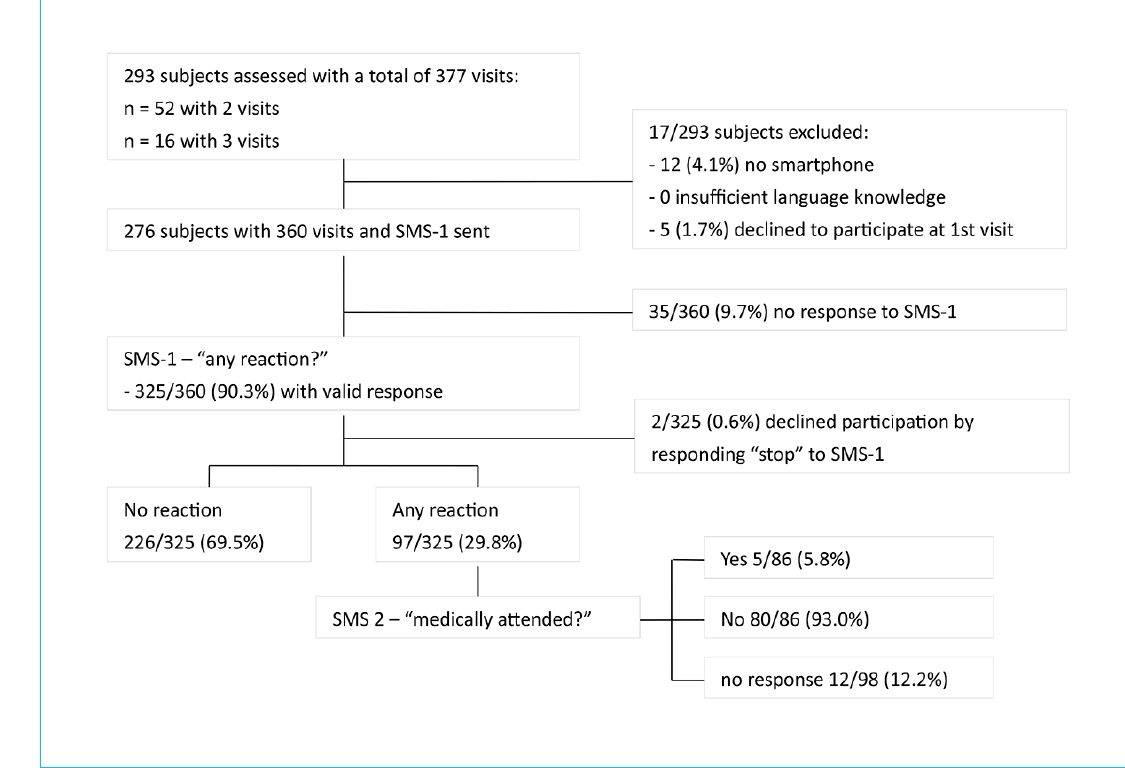
Figure 1: Study flow chart. SMS: short message service; SMS-1: first SMS asking whether a reaction occurred following vaccination; SMS-2: second SMS asking whether the reaction resulted in a consultation with a